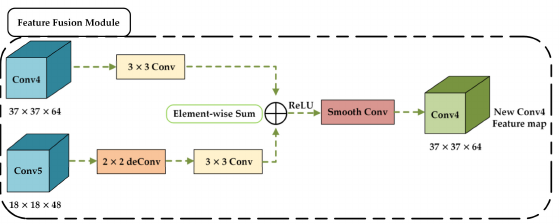
Figure 4. An example of the structure of the feature fusion module used in the proposed SSD7-FFAM.